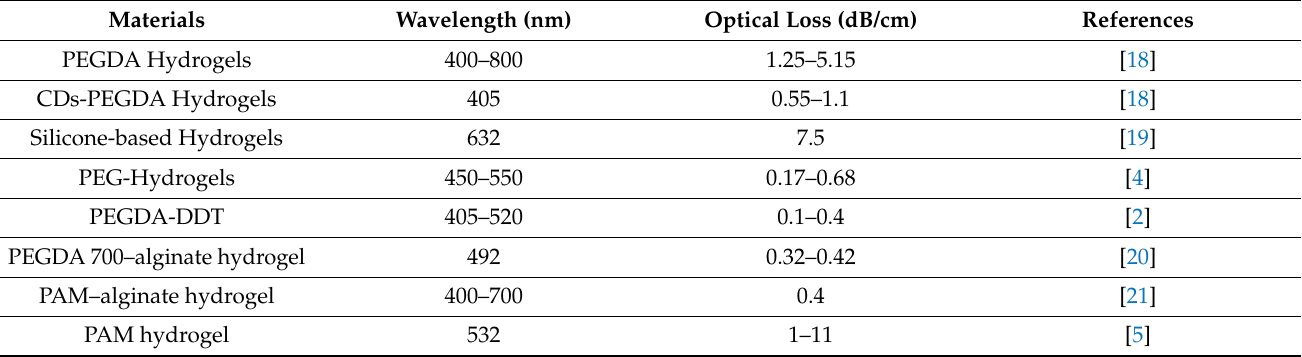
Table 2. Optical loss values of several hydrogels previously described in the